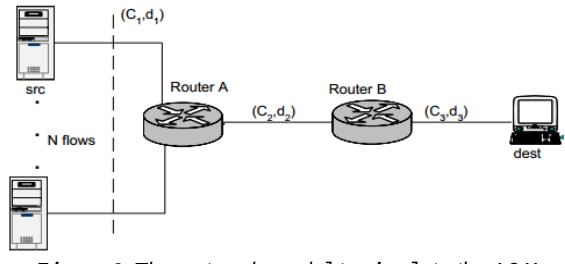
Table 5. Fuzzy rule system of FLREM Figure 6. The network model to simulate the AQM In the model, using the communication protocol TCP / NewReno with congestion window is 240 packets, each packet size of 1000 bytes. Buffer size of all queues is 500 packets. Queue of the bottleneck link is placed between the router-router-A and B, respectively installing AQM algorithms queue manager at bottlenecks, all other links placed queue management mechanism passive. Reference queue length for the mechanism to be set to 200 packets (40% buffer size). Sampling distance is 0.1 seconds, the